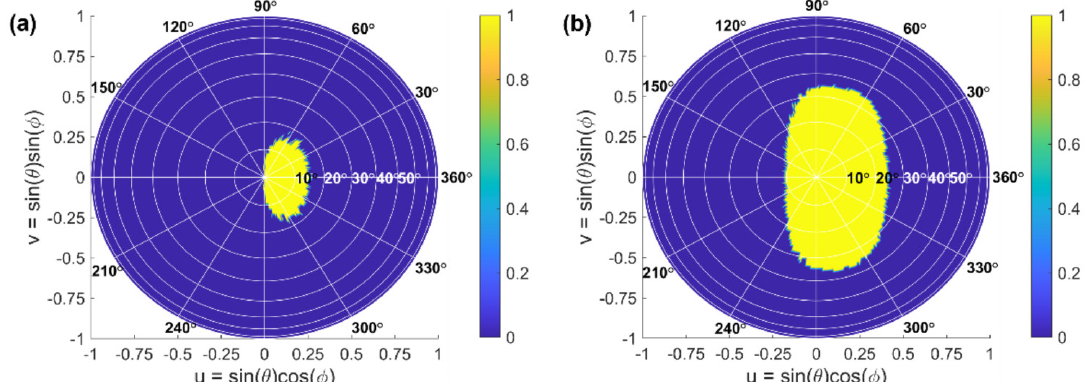
Figure 7. Projection of the steering range onto a hemisphere for ( a ) Array #1 and ( b ) Array #2 , both operating at 1550 nm wavelength. The bright area represents the set of all steerable angles, where the sidelobe suppression is larger than 10 dB, and the dark area represents non-steerable angles.